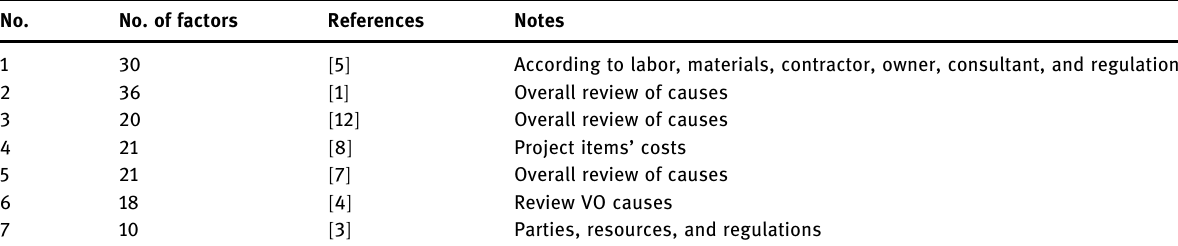
Table 1: Number of main COs caused in previous studies No. No. of factors